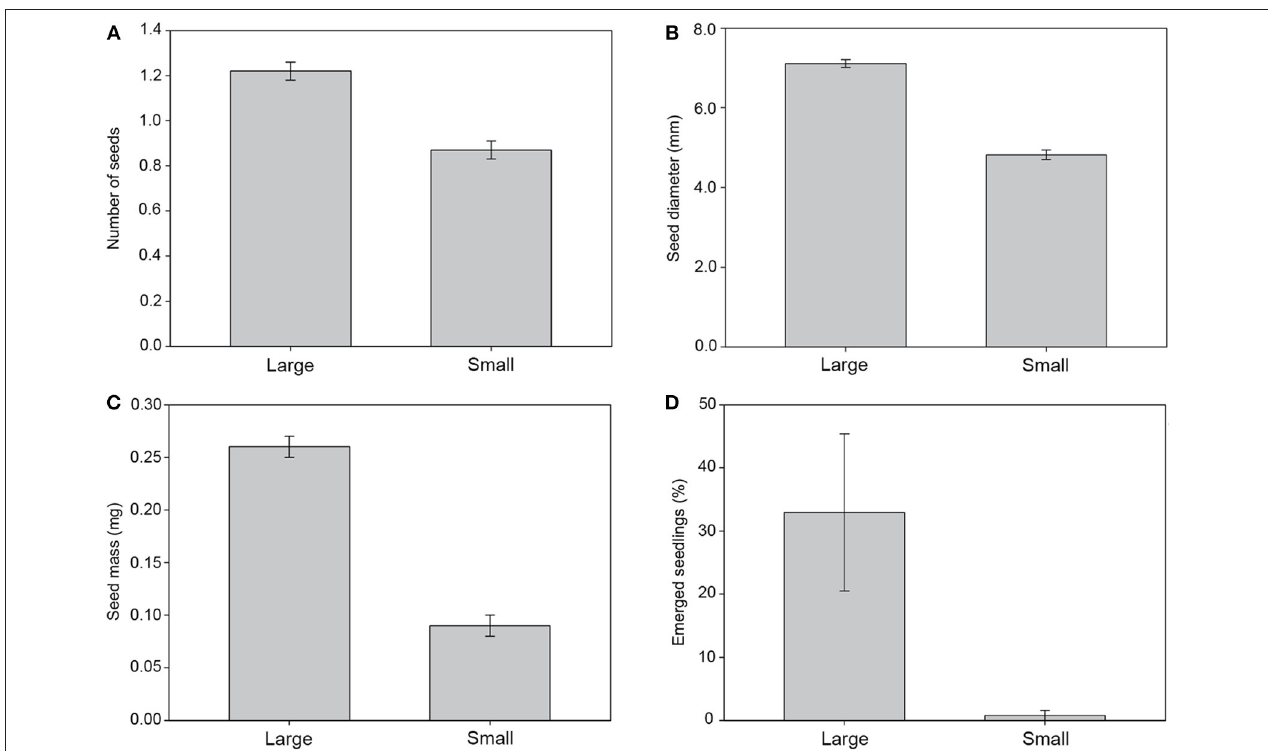
FIGURE 2 | Relationship of fruit type (large vs. small) to the number of seeds it contained (A) , seed width (B) , seed mass (C) , and seedling emergence success (D)